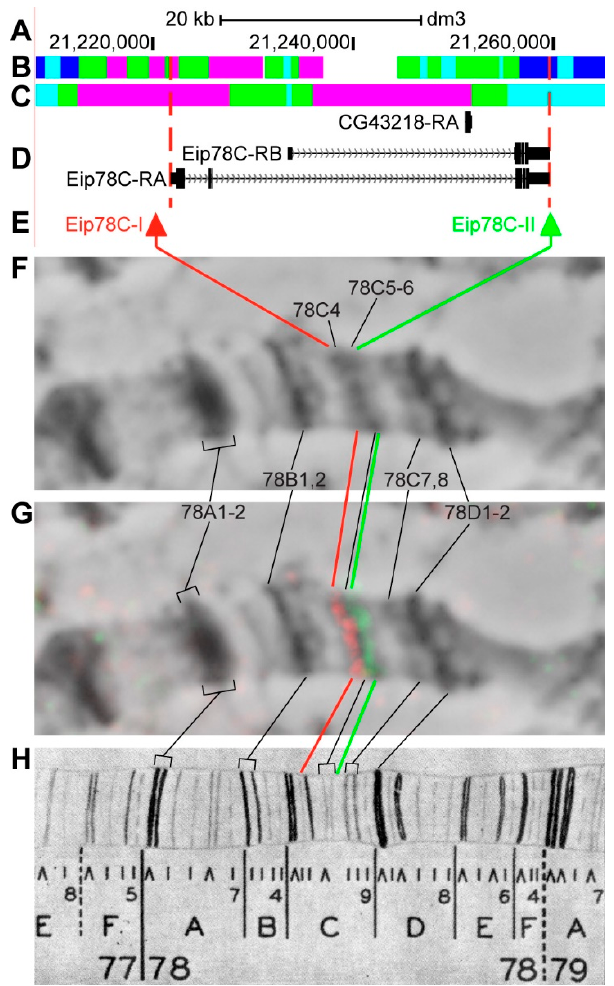
Figure 20. Localization of the Eip78C gene in the 78C region (the gene is bound by red dotted lines). (A) the scale (kb) and genomic coordinates (bp); (B) the four chromatin-state model [39]; (C) the chromatin condensation level model [32]; (D) genes location (arrow lines show the gene orientation and black bars indicate the location of gene exons); (E) probes location; (F) phase-contrast micrograph of the region; (G) combined FISH signals; and, (H) C. Bridges’ chromosome map [25].